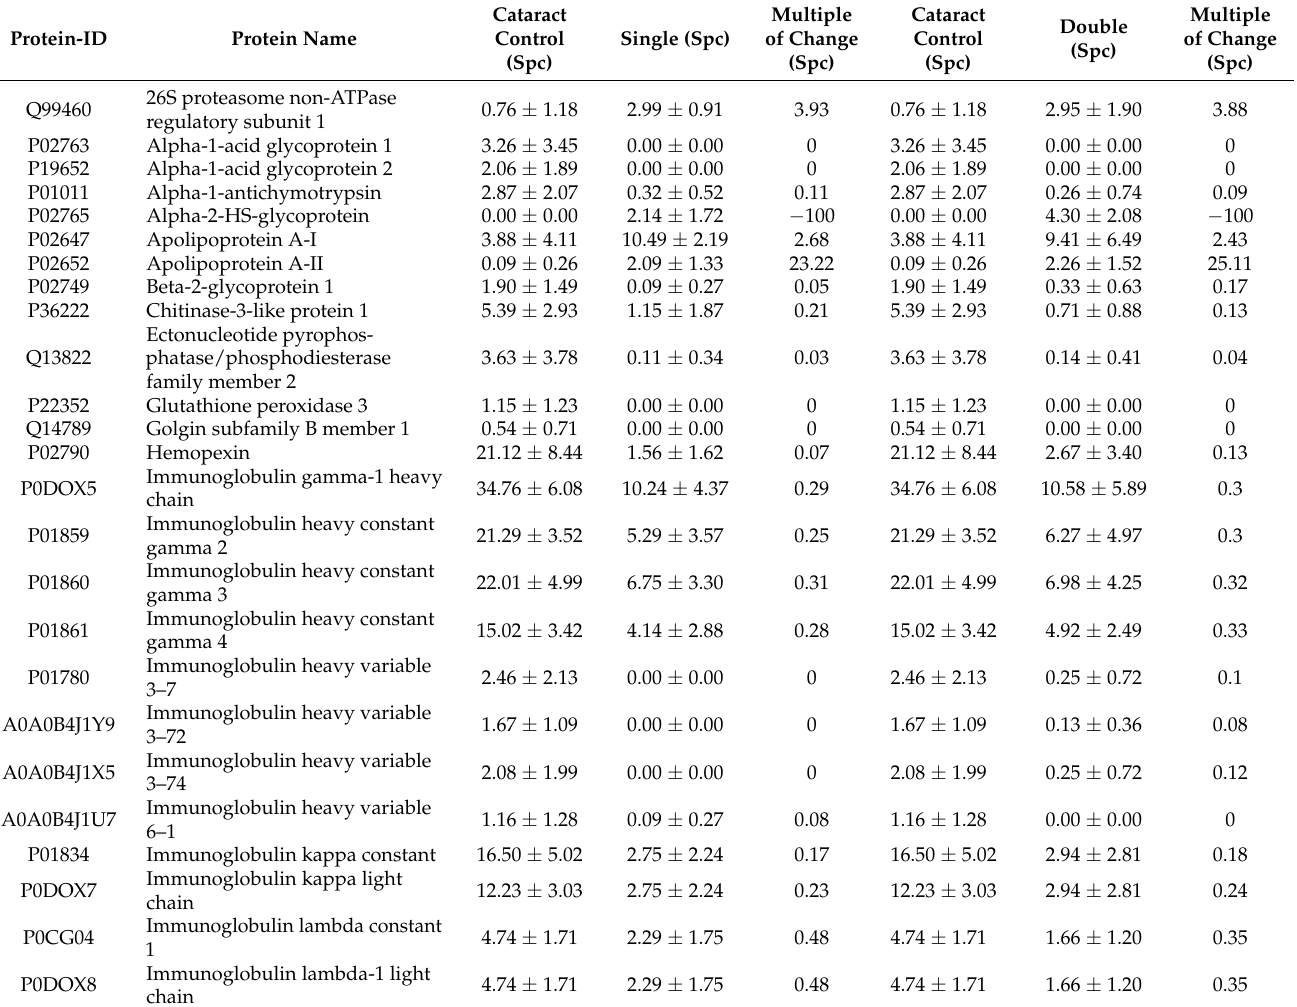
Table 4. List of selected potential biomarker